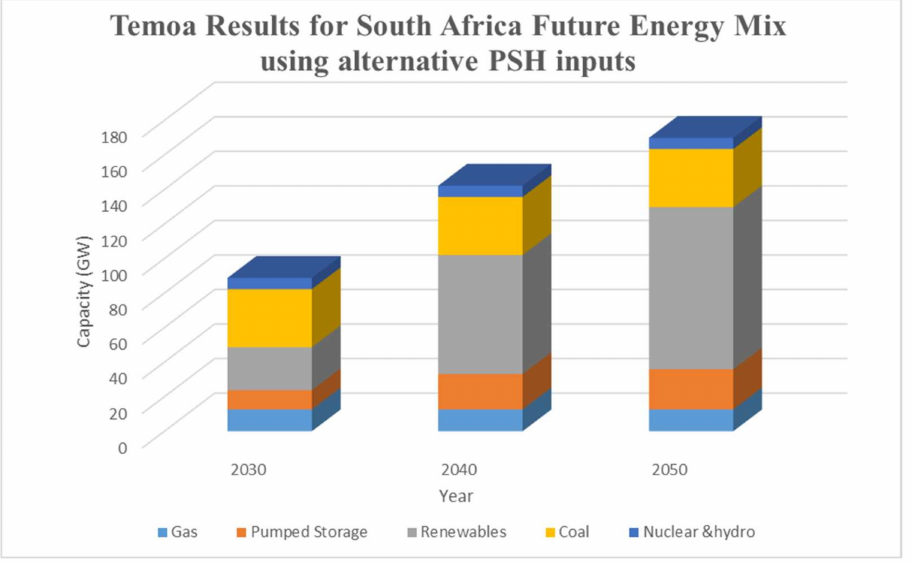
Figure 7. Temoa Results for South Africa Future Energy Mix using alternative PS